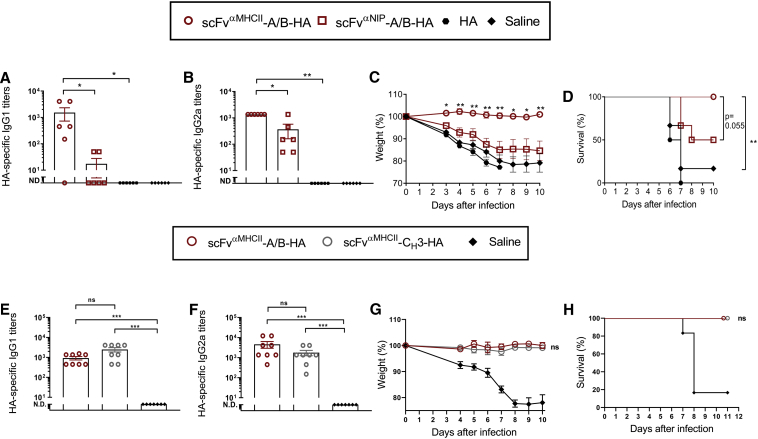
MHCII-Targeting A/B Heterodimeric and CH3 Homodimeric DNA Vaccines Both Confer Complete Protection against Influenza InfectionIn (A)–(D), BALB/c mice were vaccinated with 100 μg of (two plasmids) DNA i.m./EP with the indicated A/B heterodimeric vaccines expressing HA from PR8 (H1N1). In (E) and (F), A/B heterodimeric and CH3-based homodimeric vaccines were compared, using 100 μg (A/B heterodimer, two plasmids) and 50 μg (CH3 homodimer, one plasmid) of DNA i.m./EP. (A, B, E, and F) Levels of HA-specific IgG1 (A and E) and IgG2a (B and F) serum antibodies 6 weeks after immunization (mean ± SEM, **p < 0.01, Mann-Whitney test; ND, not detectable). (C and G) 15 (C) or 4 (G) weeks after vaccination, the mice were infected with a lethal dose of PR8 influenza virus (7.5 × LD50). Weight was followed for 10 days (mean ± SEM; *p < 0.05, **p < 0.01, Mann-Whitney test, comparing targeting to non-targeting vaccines). (D and H) Survival curves of the vaccinated mice. Non-significant (ns, p = 0.0549) or significant p values are indicated (**p < 0.01, Mantel-Cox test). n = 6/group in (A)–(D), n = 8/group in (E)–(H). Weight loss of 20% was defined as the humane endpoint, at which time point the mice were euthanized.